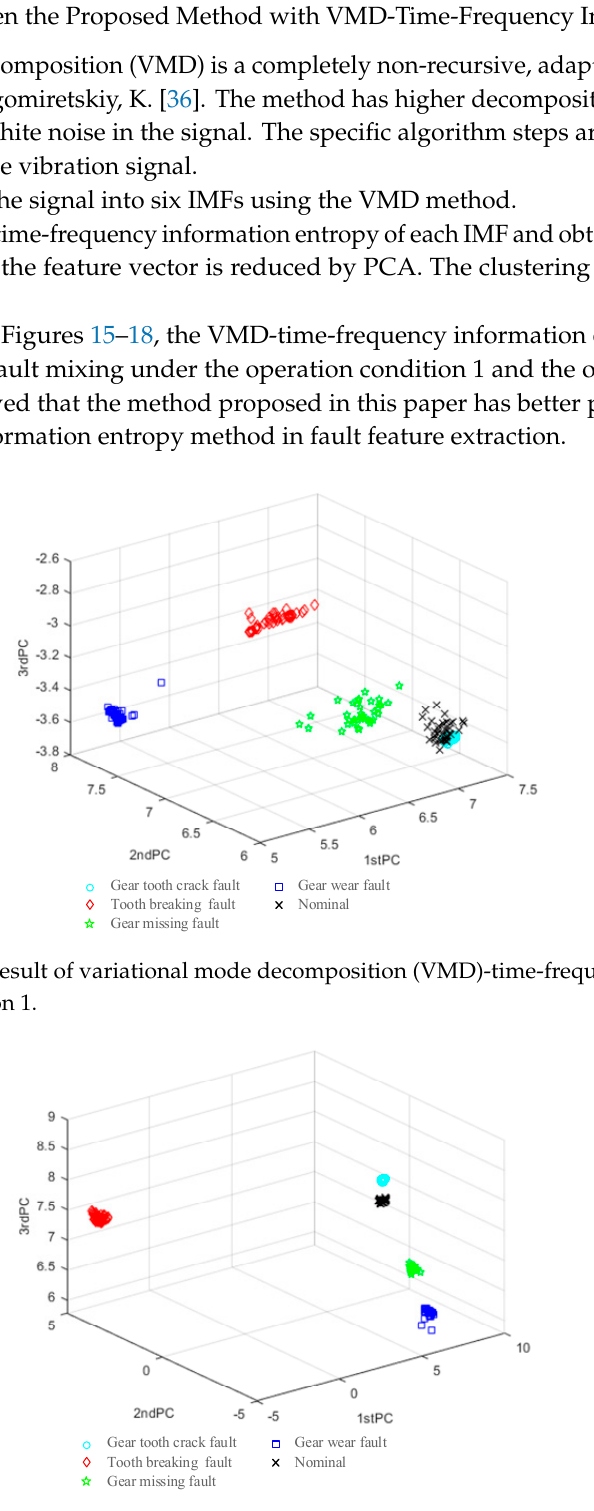
Figure 16. Clustering result of VMD-time-frequency information entropy under condition 2.